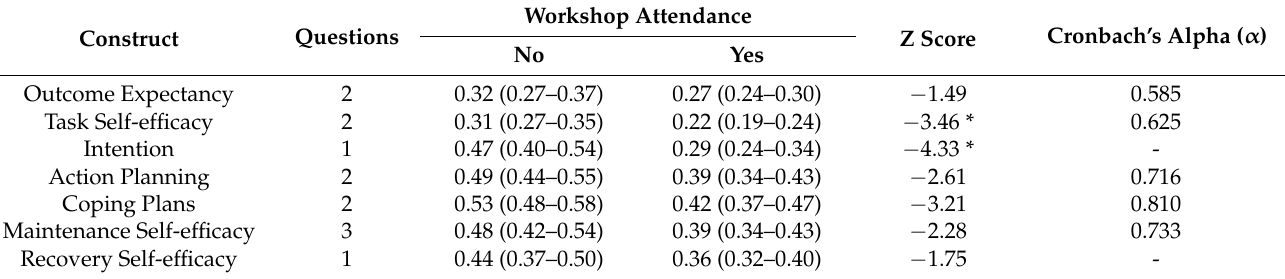
Table 2. Post-season construct score with 95% confidence intervals.